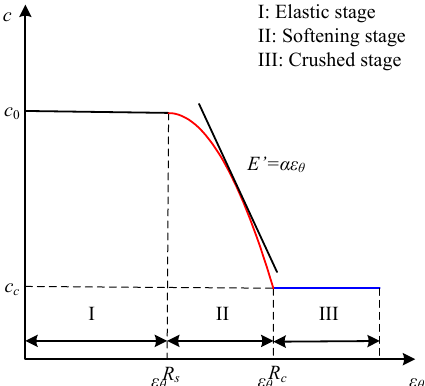
Figure 3. Nonlinear strain-softening model of cohesion.